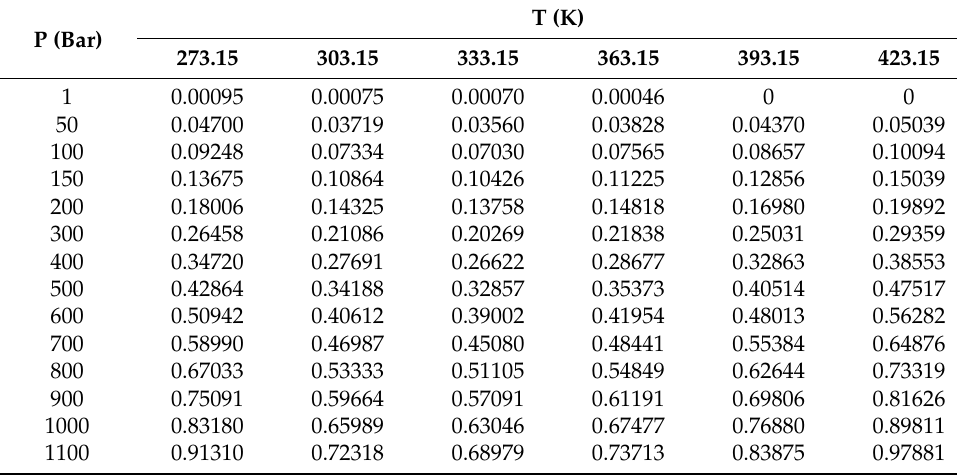
Table 4. Calculated H 2 solubility (mol/kg) in pure